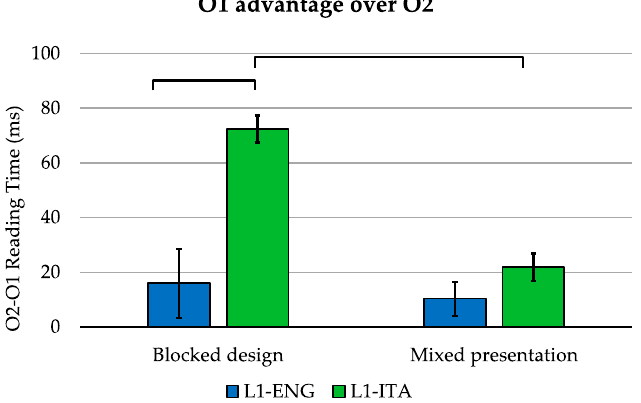
Figure 4. Reading time advantage for O1 over O2 in blocked and mixed reading tasks (accurate trials) for L1-Italian and L1-English bilinguals. Error bars indicate the standard error of the mean.